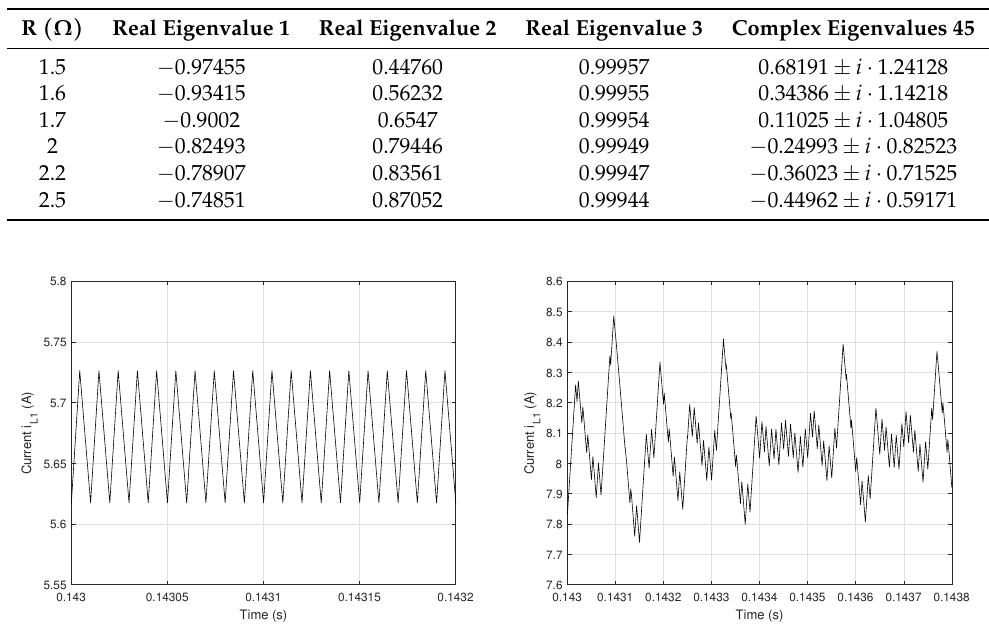
Figure 7. Time-domain waveforms for different values of R ( left panel R = 2.5 Ω , right panel R = 1.7 Ω